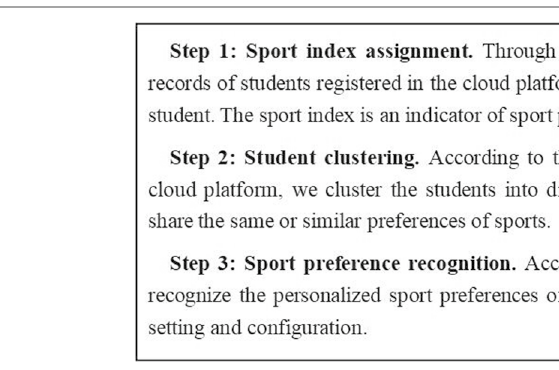
Fig. 2 Detailed procedure of